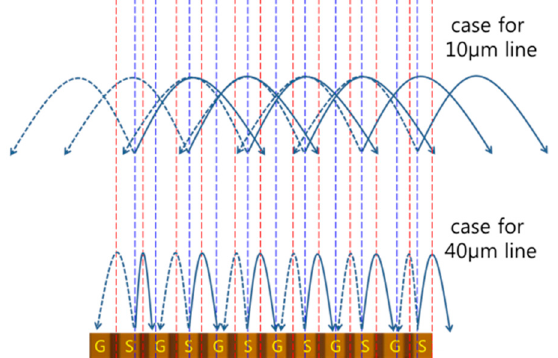
Figure 13. Qualitative electric field flux for the results shown in Figures 11 and 12 (dashed line is to distinguish the phase).